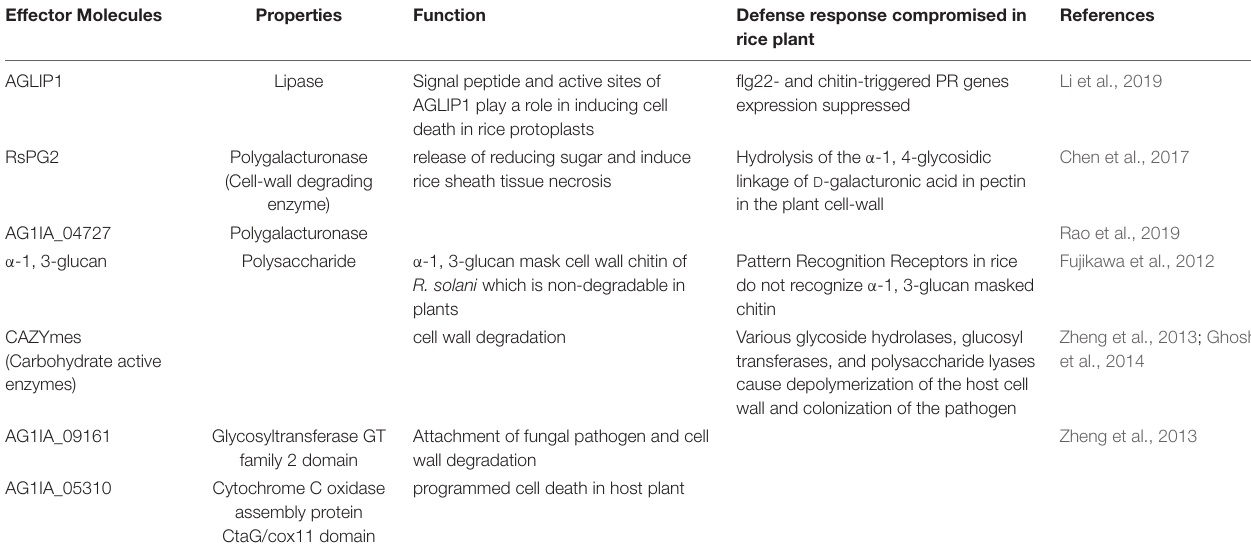
TABLE 1 | List of effector molecules related to R. solani colonization in rice